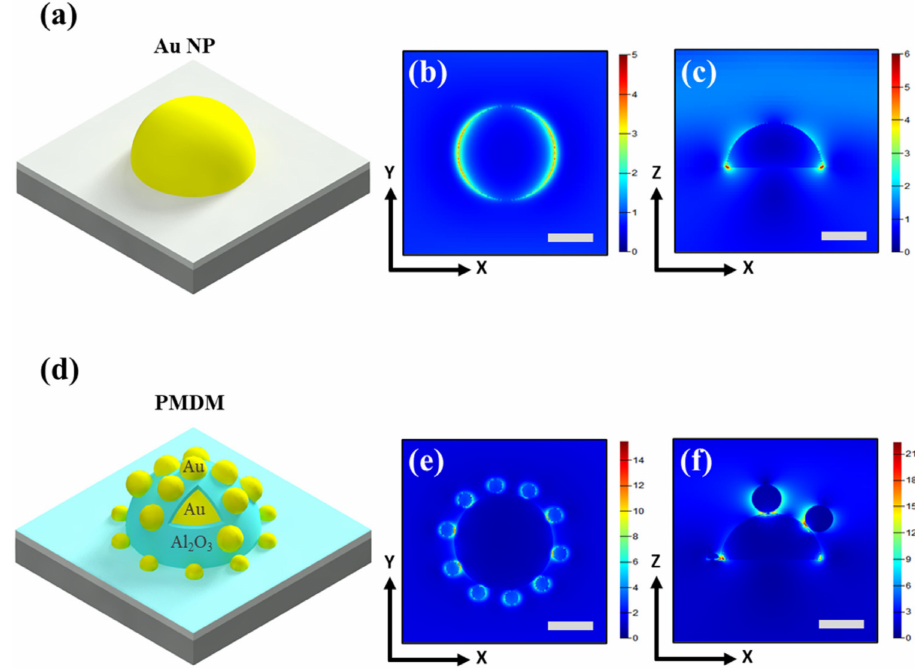
Figure 3. Finite-difference time-domain (FDTD) simulation of EM field distribution of plasmonic nanostructures under the radiation of a 532 nm laser. ( a ) Simulation model and EM field distribution of Au NP at ( b ) X-Y and ( c ) X-Z view. ( d ) Simulation model of PMDM hybrid nanostructure and corresponding EM field distribution in ( e ) X-Y and ( f ) X-Z views. Scale bar: 100